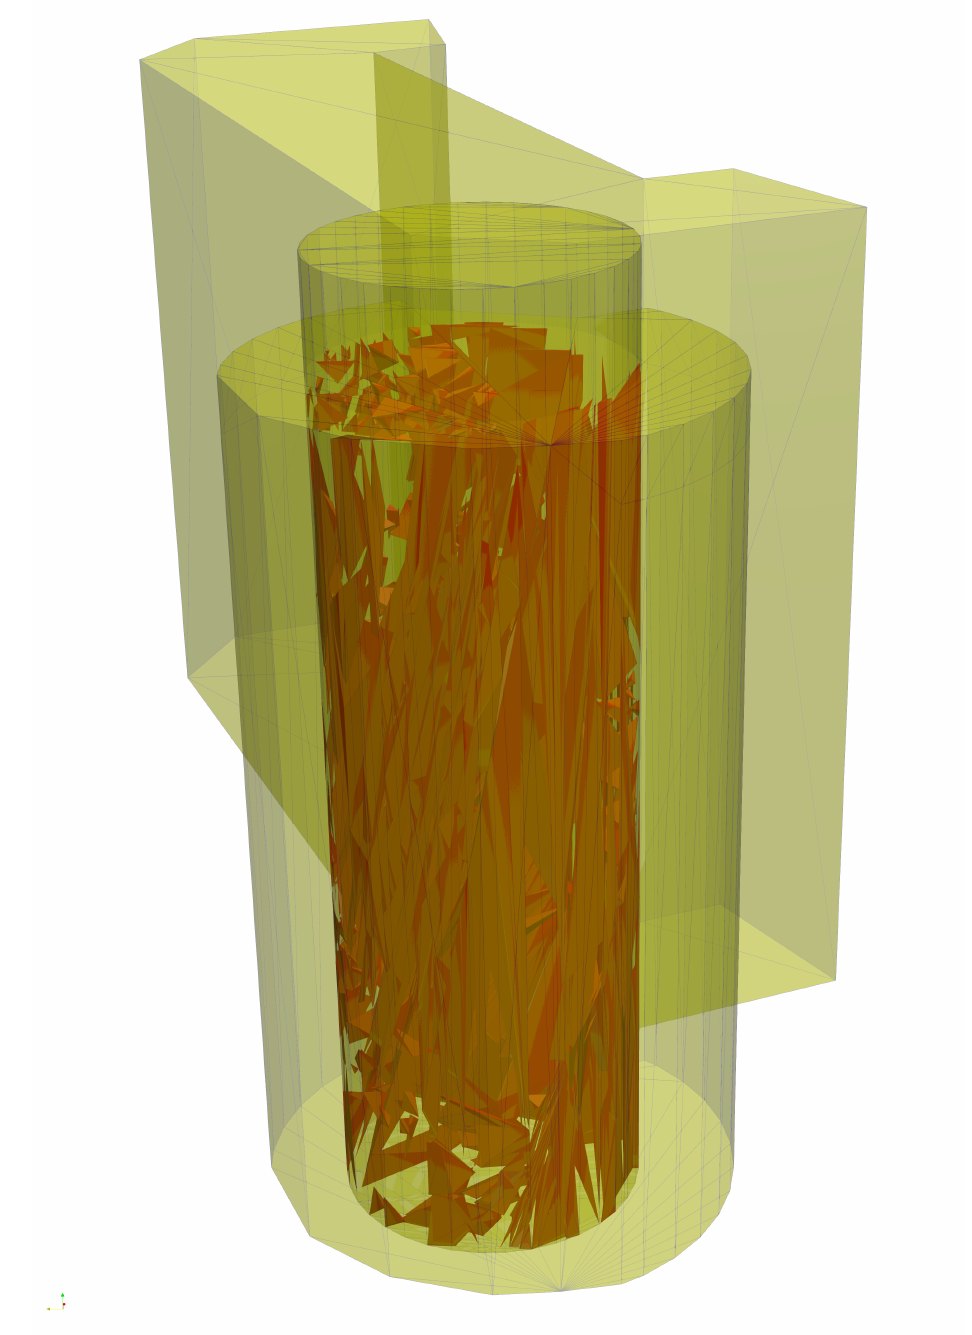
Figure 13. Result of an interior overlay as a Tetrahedron3DNet object (red) of two building parts tetrahedralised to two tetrahedron complexes (yellow) in the shape of cylinders. This is an example of a Tetrahedron3DNet object with many tetrahedron complexes of Table